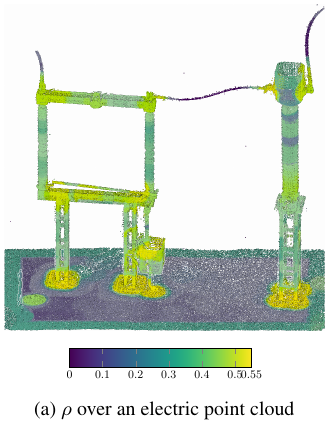
Figure 5. 3D point cloud from an electrical substation. Instability values are shown on the given colour scale. We observe high values of ρ on edges and low values on flat zones.